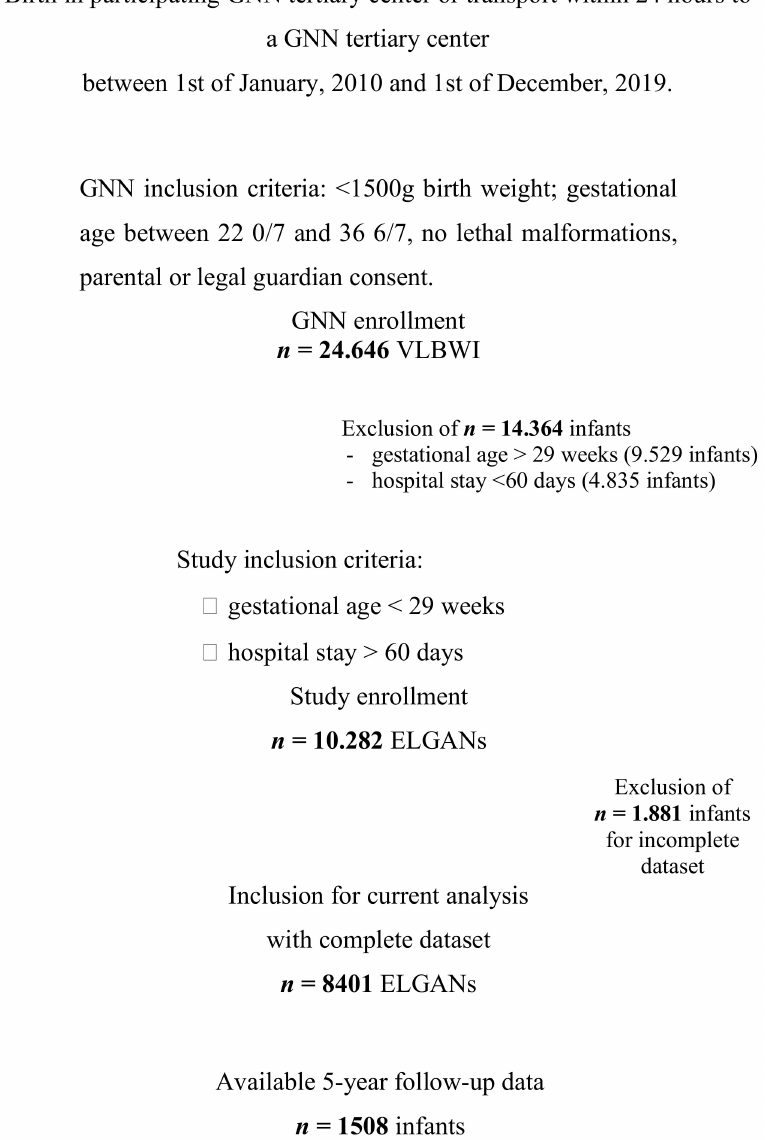
Figure 1. In- and exclusion criteria for the current analysis. GNN, German Neonatal Network; VLBWI, very low birth weight infant; ELGAN, extremely low gestational age